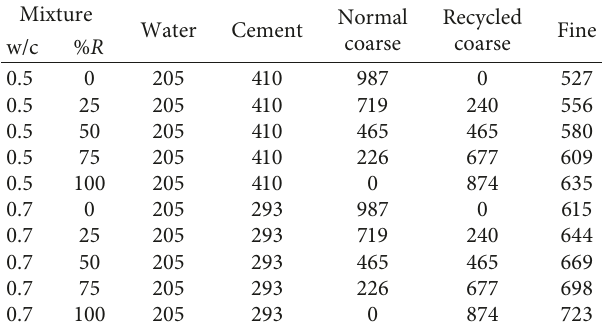
Table 2: Mixture design (kg/m 3